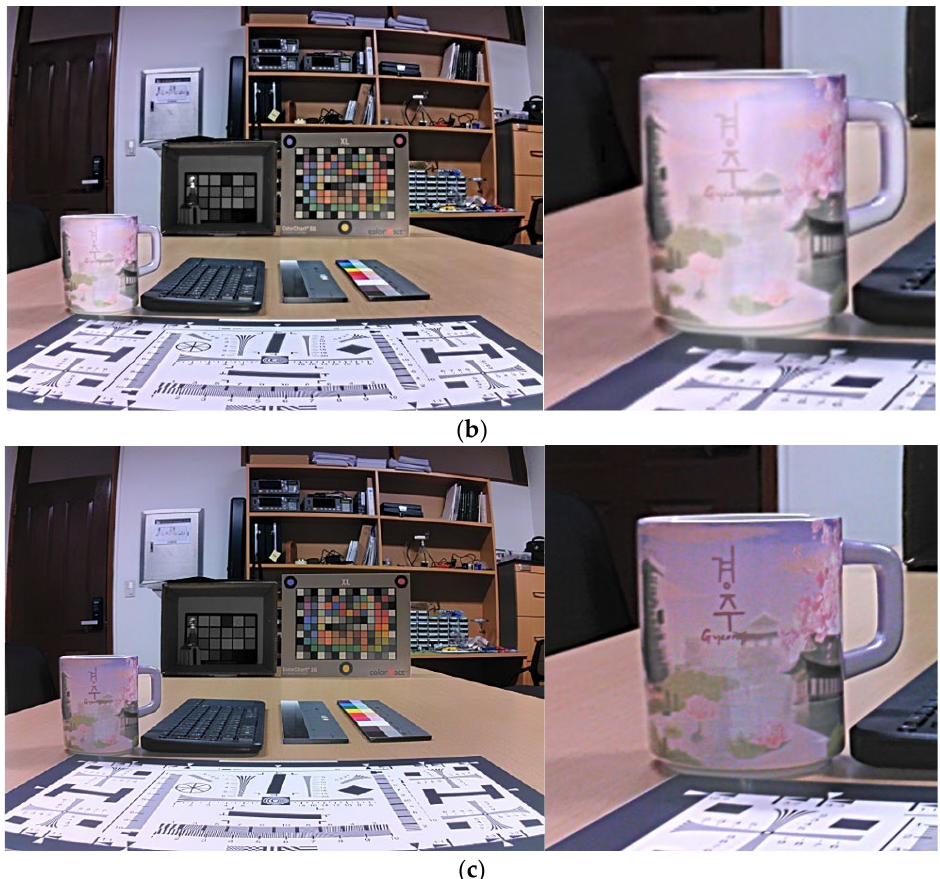
Figure 12. Comparison of various synthesis results: ( a ) result with a bilateral filter map, ( b ) result with an associative bilateral filter map, ( c ) result with a proposed synthesis map.